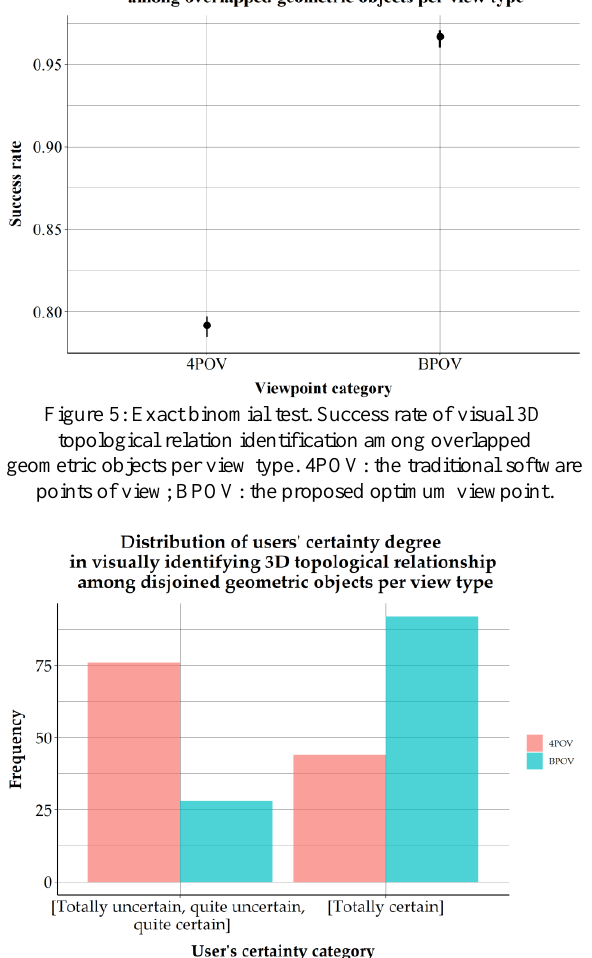
Figure 6: Distribution of users’ certainty degree in visually identifying 3D topological relationship among disjoined geometric objects per view type; 4POV: the traditional software points of view; BPOV: the proposed optimum viewpoint. User’s certainty categories totally uncertain , quite uncertain and quite certain have been merged to meet the minimum number of observations per class (5).